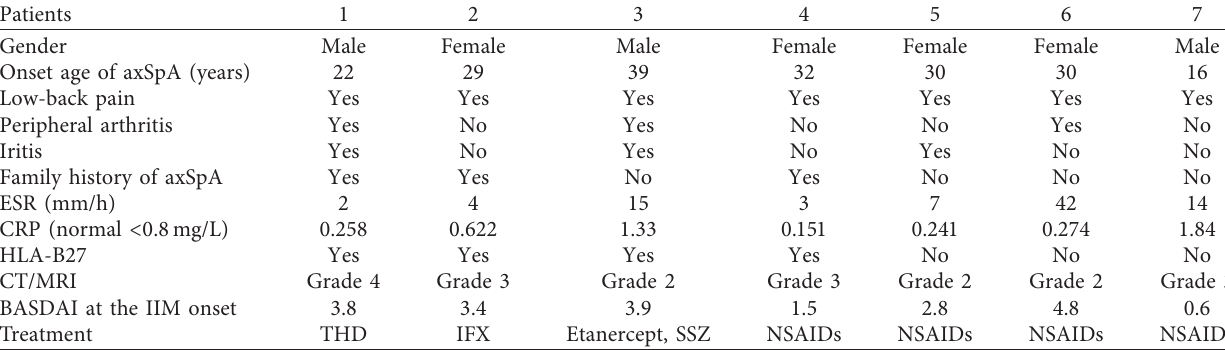
Table 1: Clinical characteristics of axSpA.